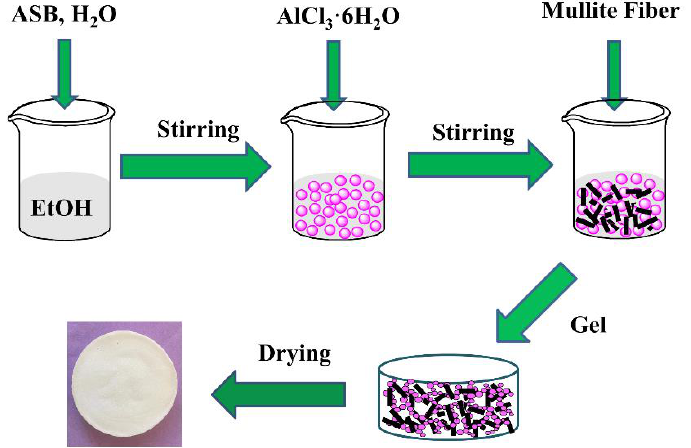
Figure 8. Schematic illustration of the preparation process of the mullite fiber-reinforced alumina aerogels.